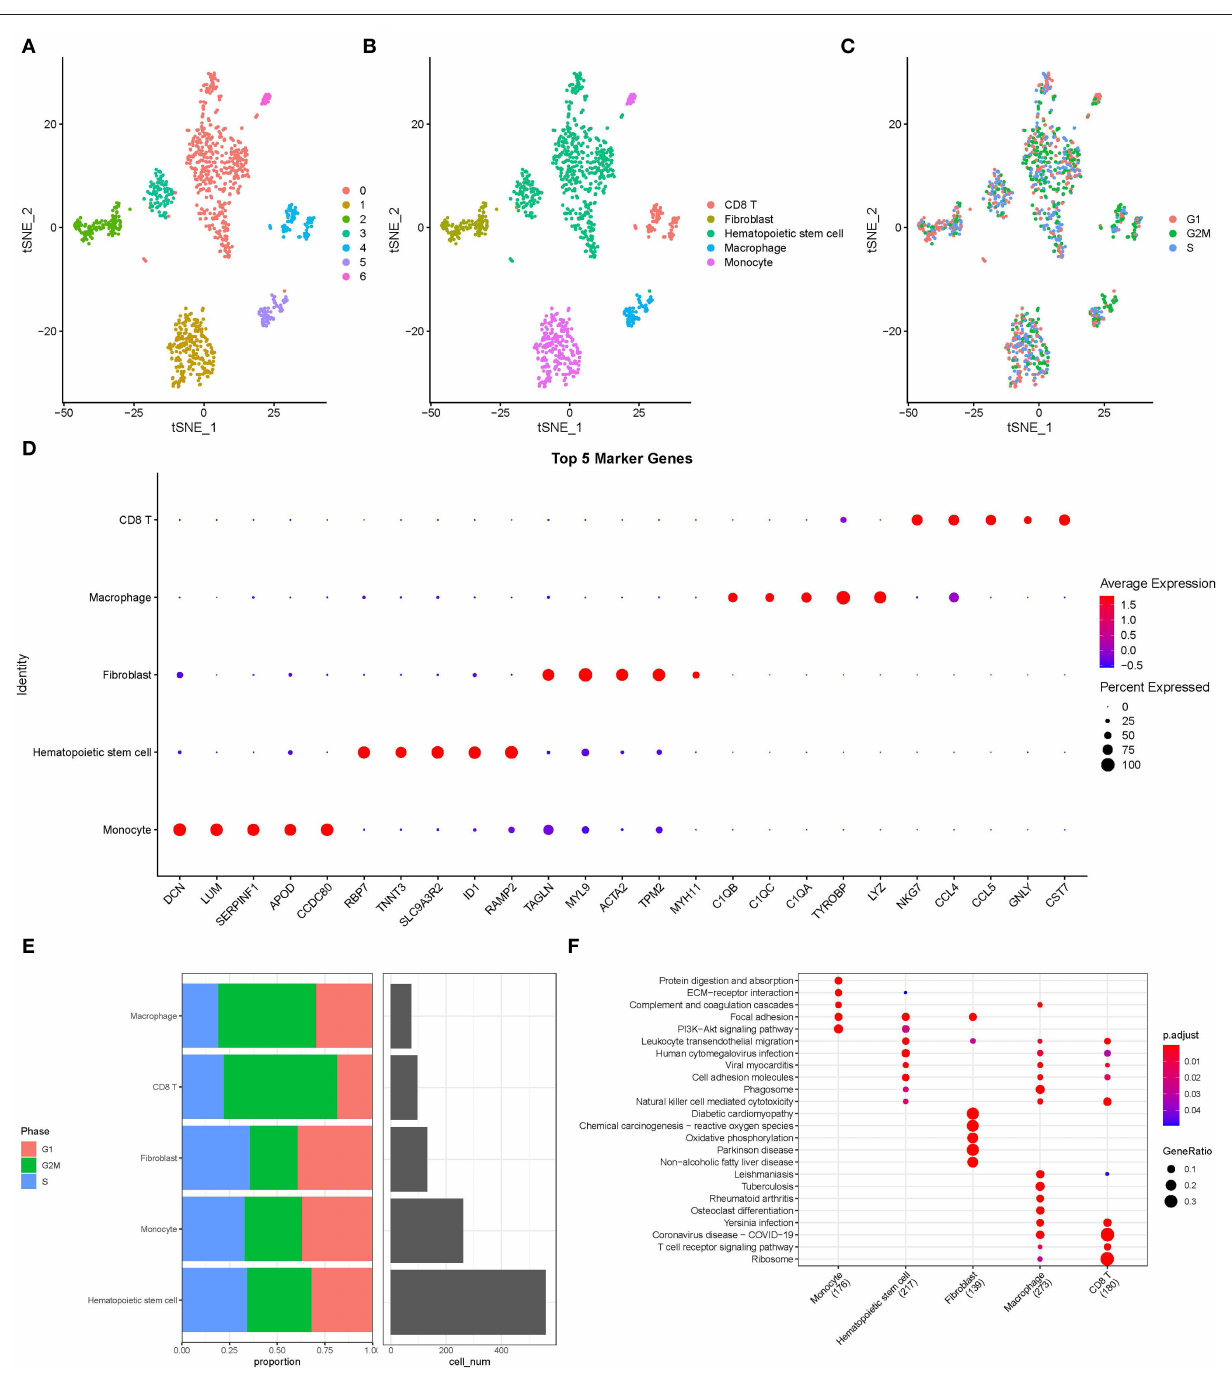
Frontiers in Public Health |